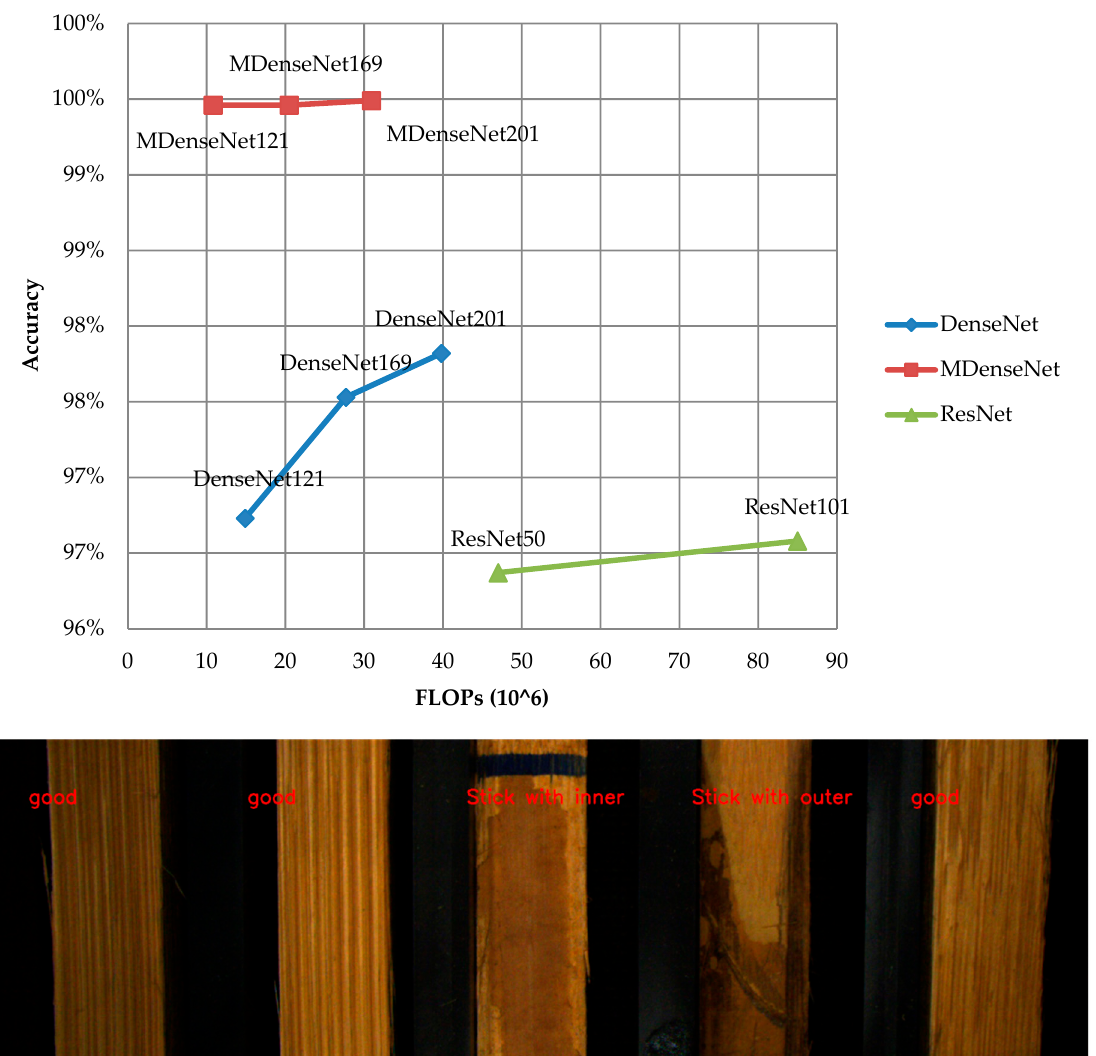
Figure 10. Image prediction final result.